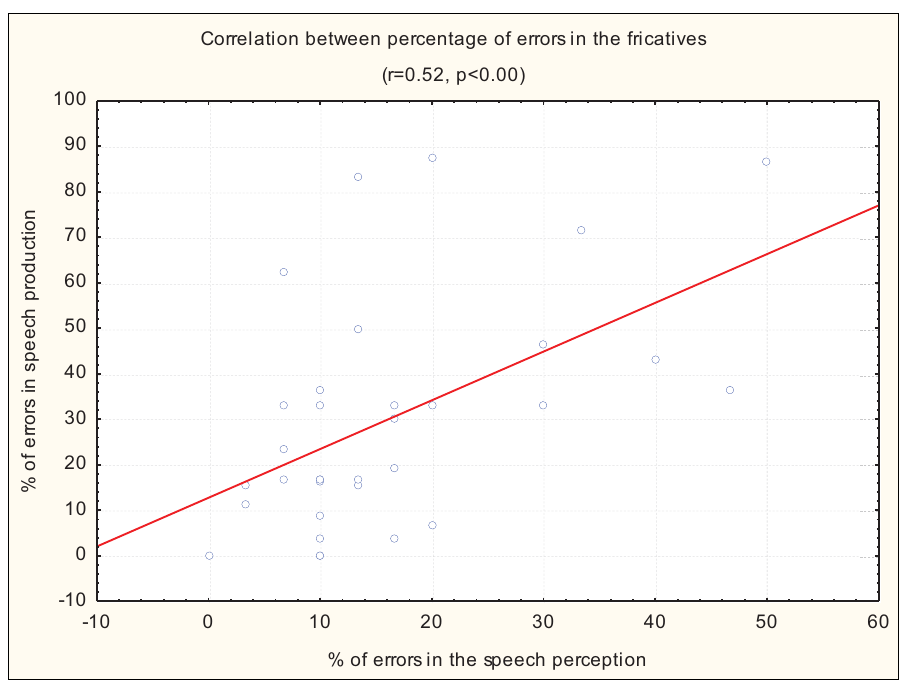
Figure 3: Correlation between speech perception errors and speech production errors in the fricatives